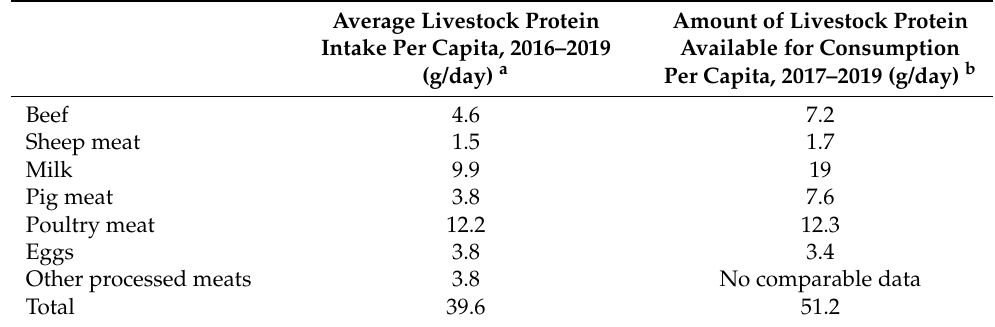
Table 4. Average intake of livestock protein and amount available for consumption per capita in UK,